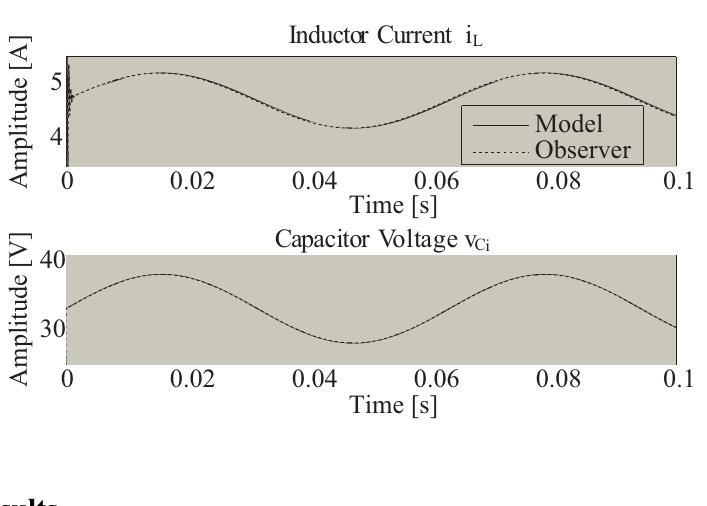
(b) Zoom from 40.5 ms to 41.5 ms